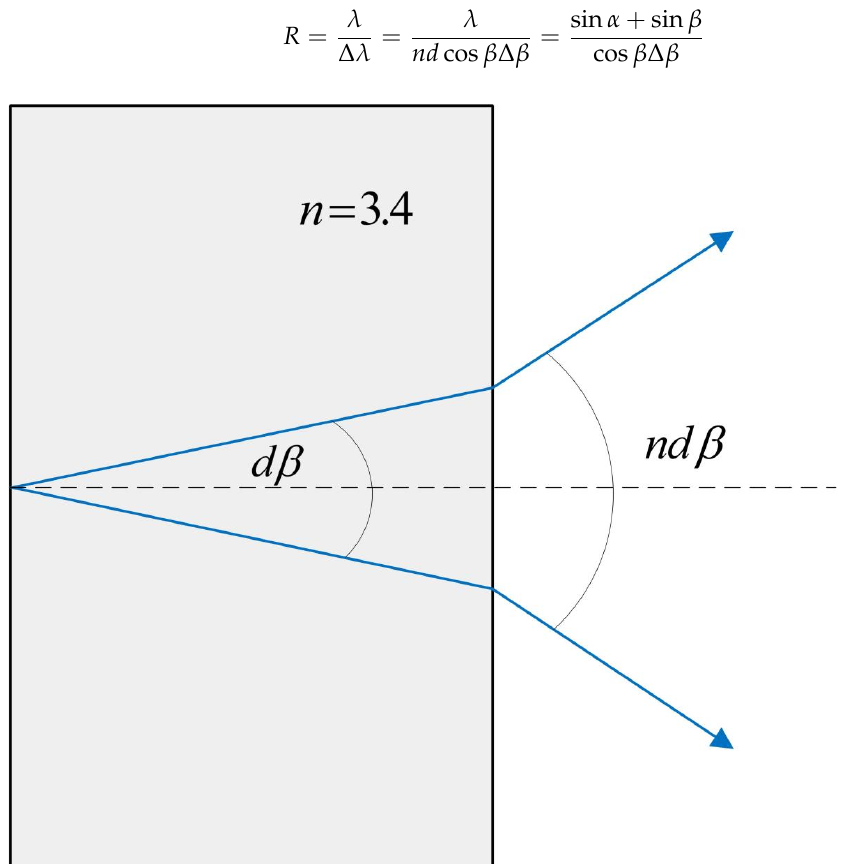
Figure 4. Increase in dispersion on the exiting immersion. Immersion gratings of infrared materials such as silicon and germanium have